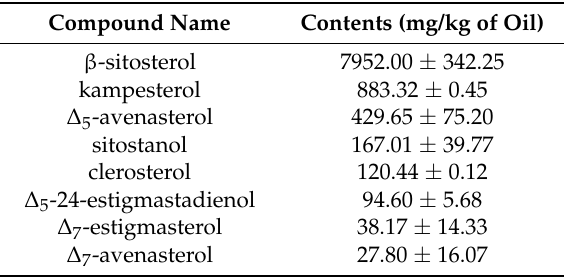
Table 3. Sterol content of EPO ( Oenothera biennis L.)